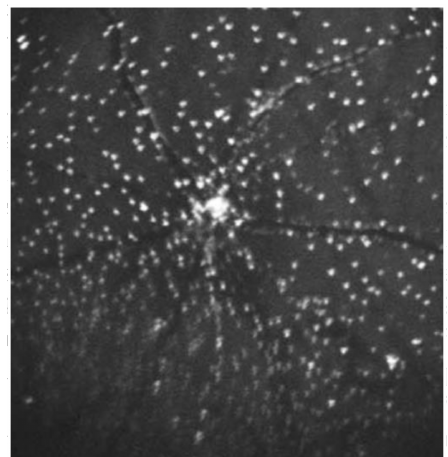
Figure 4. DARC imaging demonstrating the detection of fluorescently-labelled annexin A5 molecules in apoptosing retinal ganglion cells in a rat model of ocular hypertension [102]. The model is formed using the injections of hypertonic saline into episcleral veins. Fluorescent markers have been introduced by intravitreal injections of ANX776 and imaged using confocal scanning laser ophthalmoscopy. The confluent staining at the optic nerve head is as yet of unknown significance, but may represent axonal staining as the nerve fibers enter the optic